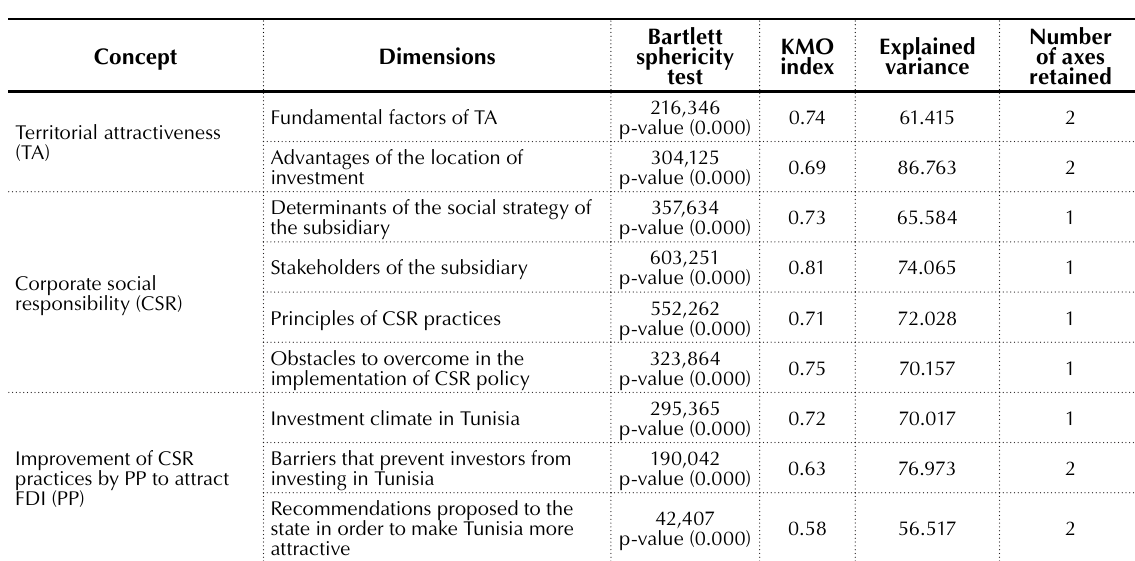
Table 4. Concept’s